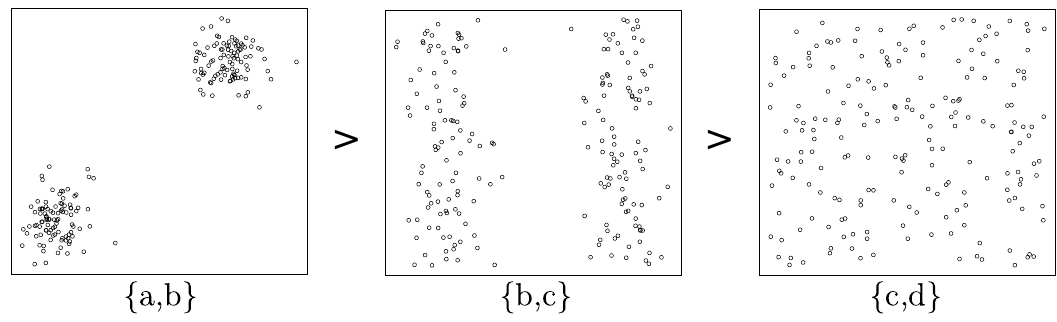
Figure 4. The significance (relative importance) order of attribute subsets— and c, d { }